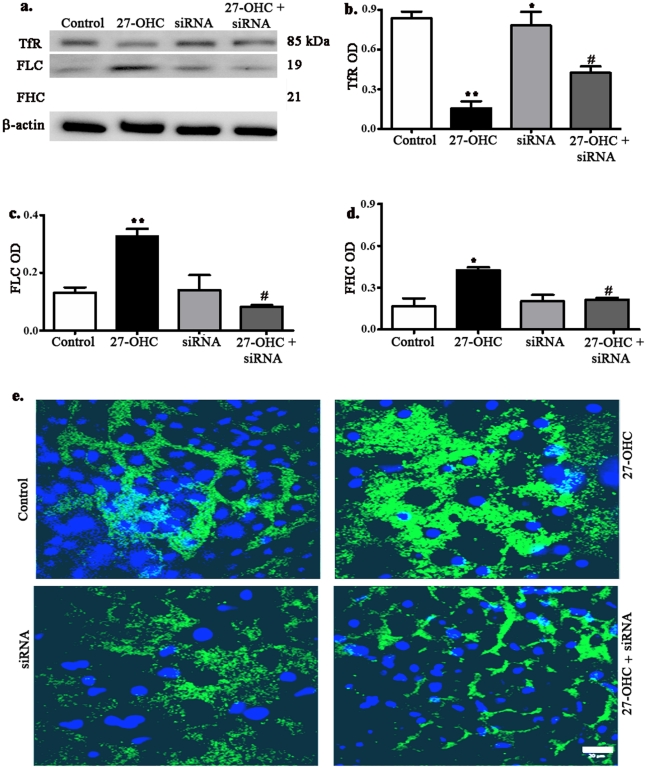
siRNA to gadd153 reduces alterations in iron homeostasis caused by 27-OHC.Treatment with 27-OHC reduces transferrin receptor (TfR) levels and increases levels of ferritin light chain (FLC) as well as ferritin heavy chain (FHC) (a–d). Staining with Phen-green SK, a probe which the fluorescence of which is quenched by iron, shows an accumulation of iron in slices treated with 27-OHC compared to control slices and treatment with siRNA to gadd153 reduces the intensity of Phen-green SK staining (e). *p<0.05 and **p<0.01 versus controls; #p<0.05 versus 27-OHC.